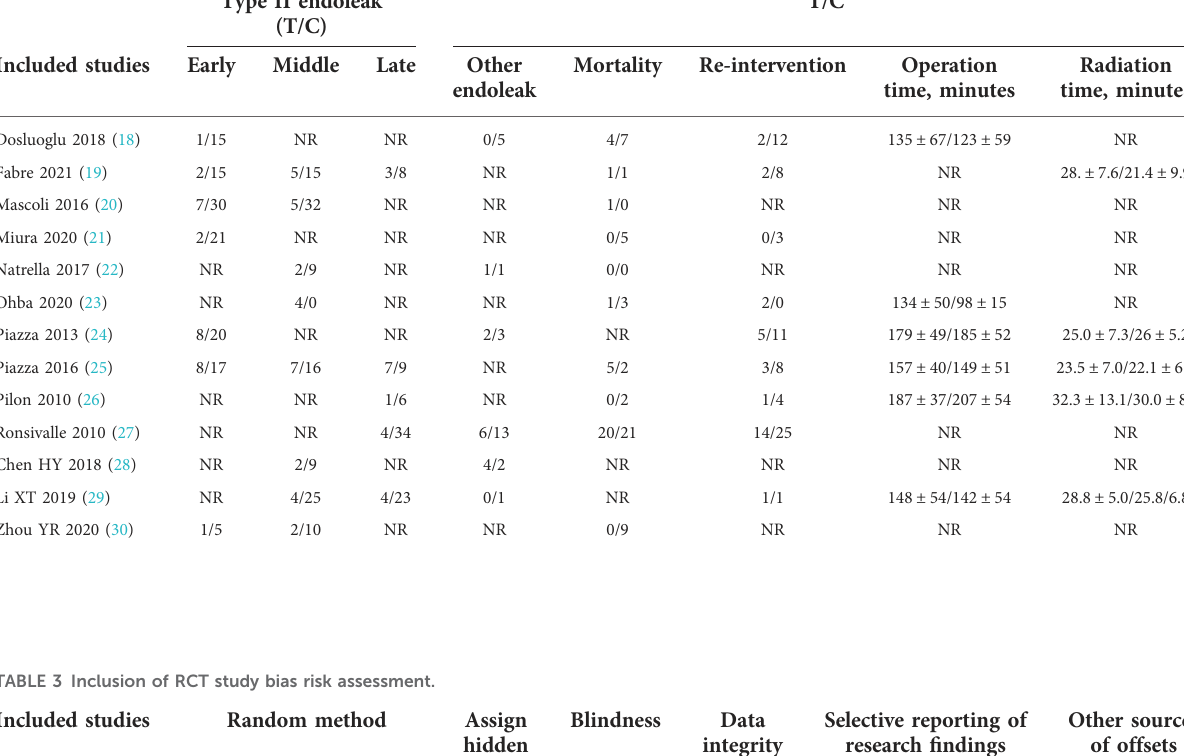
TABLE 2 Outcome measures of the included studies.